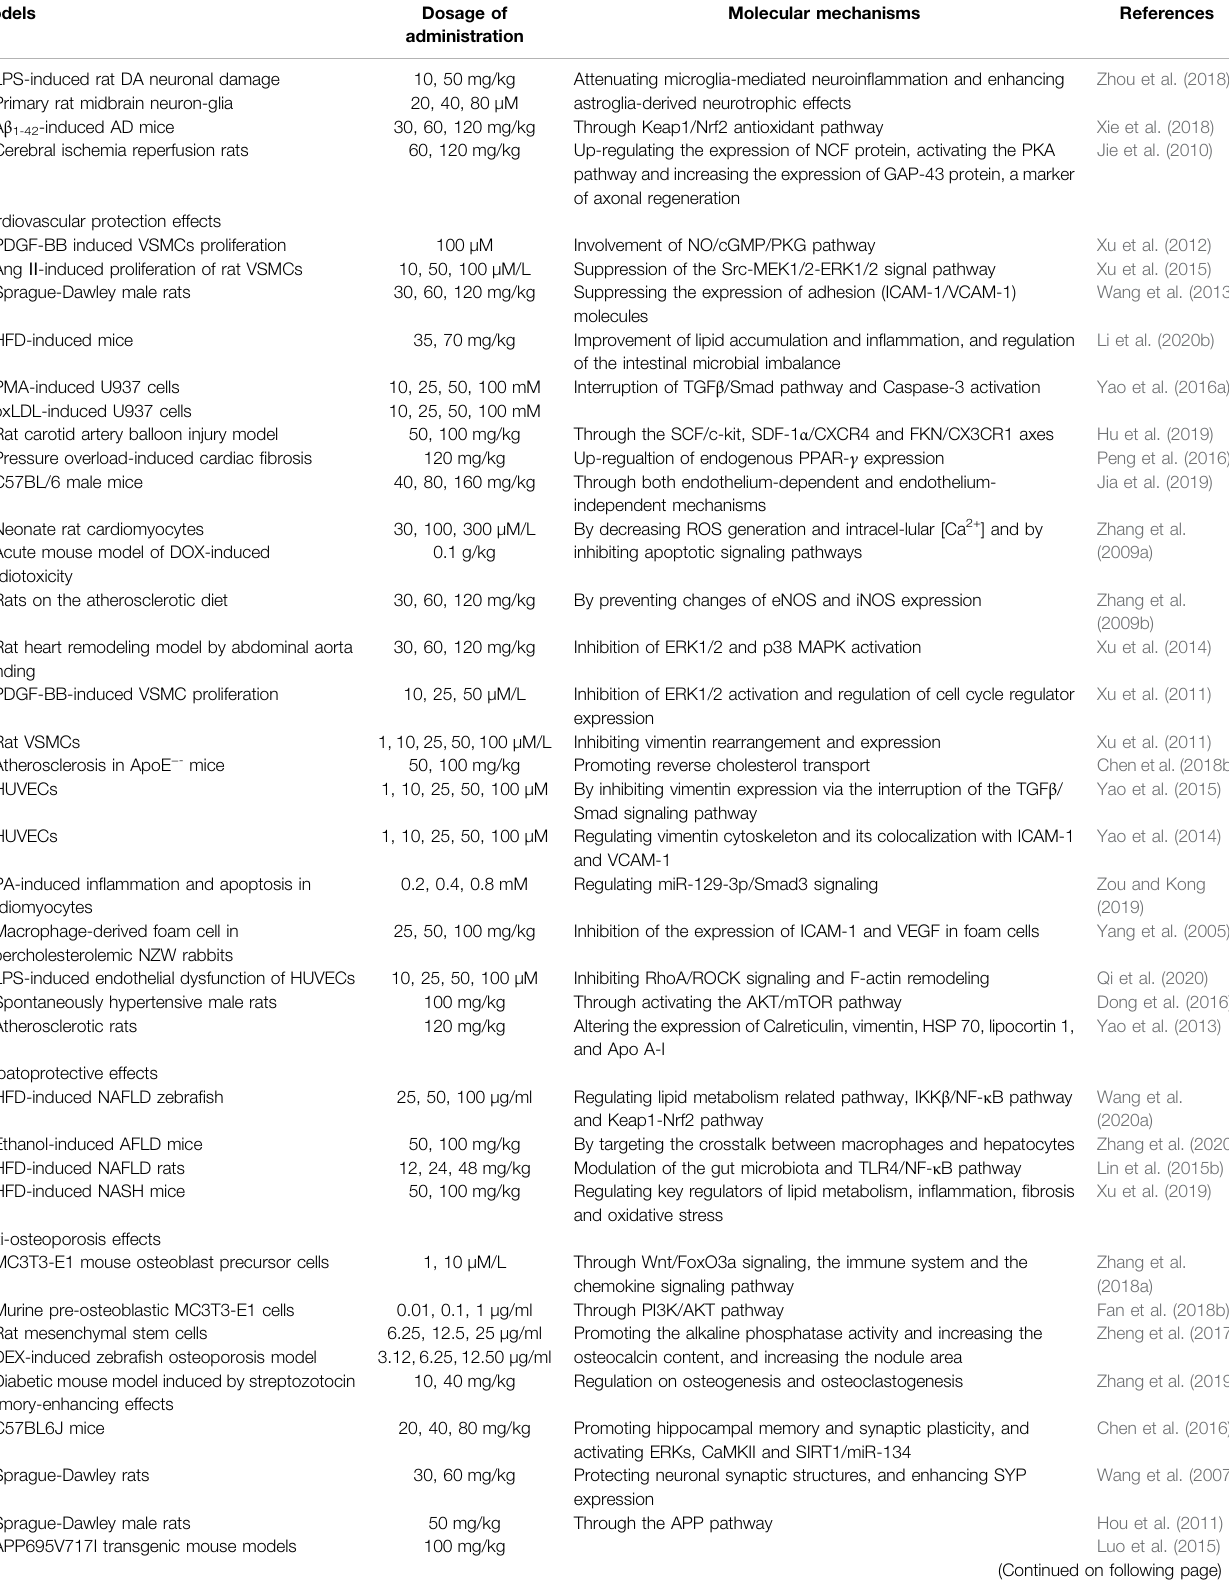
TABLE 2 | ( Continued ) Molecular mechanisms to the pharmacological activity of